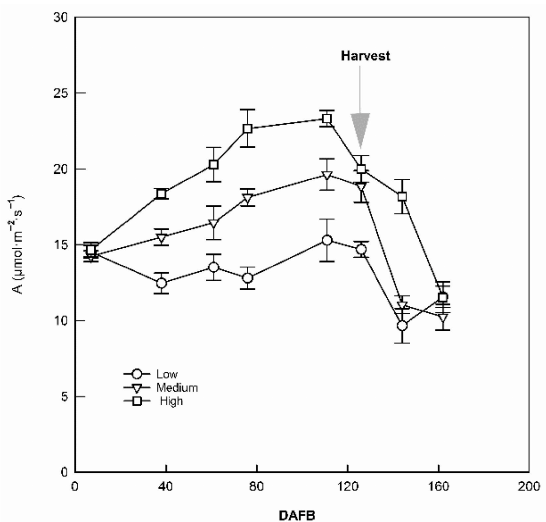
Figure 1. Effects of crop load on leaf CO 2 assimilation (A) throughout the growing season, from seven days after full bloom (DAFB, before crop load adjustment), to 162 DAFB (35 days after harvest). Each point is mean ± SE ( n = 6). The arrow indicates fruit